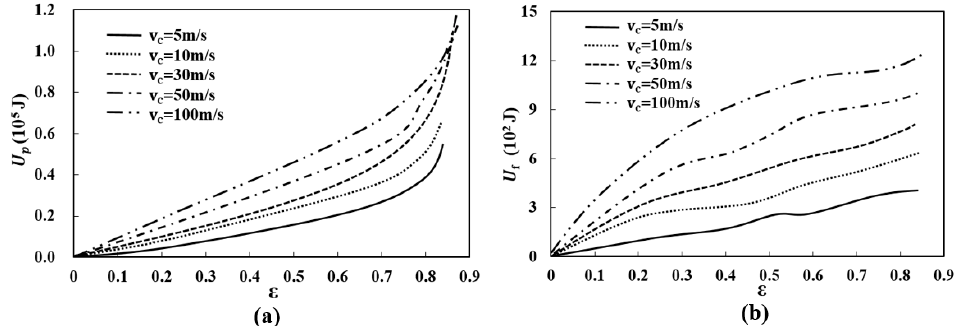
Figure 12. ( a ) Plastic energy dissipation U p versus the crushing strain ε ; ( b ) Frictional energy dissipation U f versus the crushing strain ε .